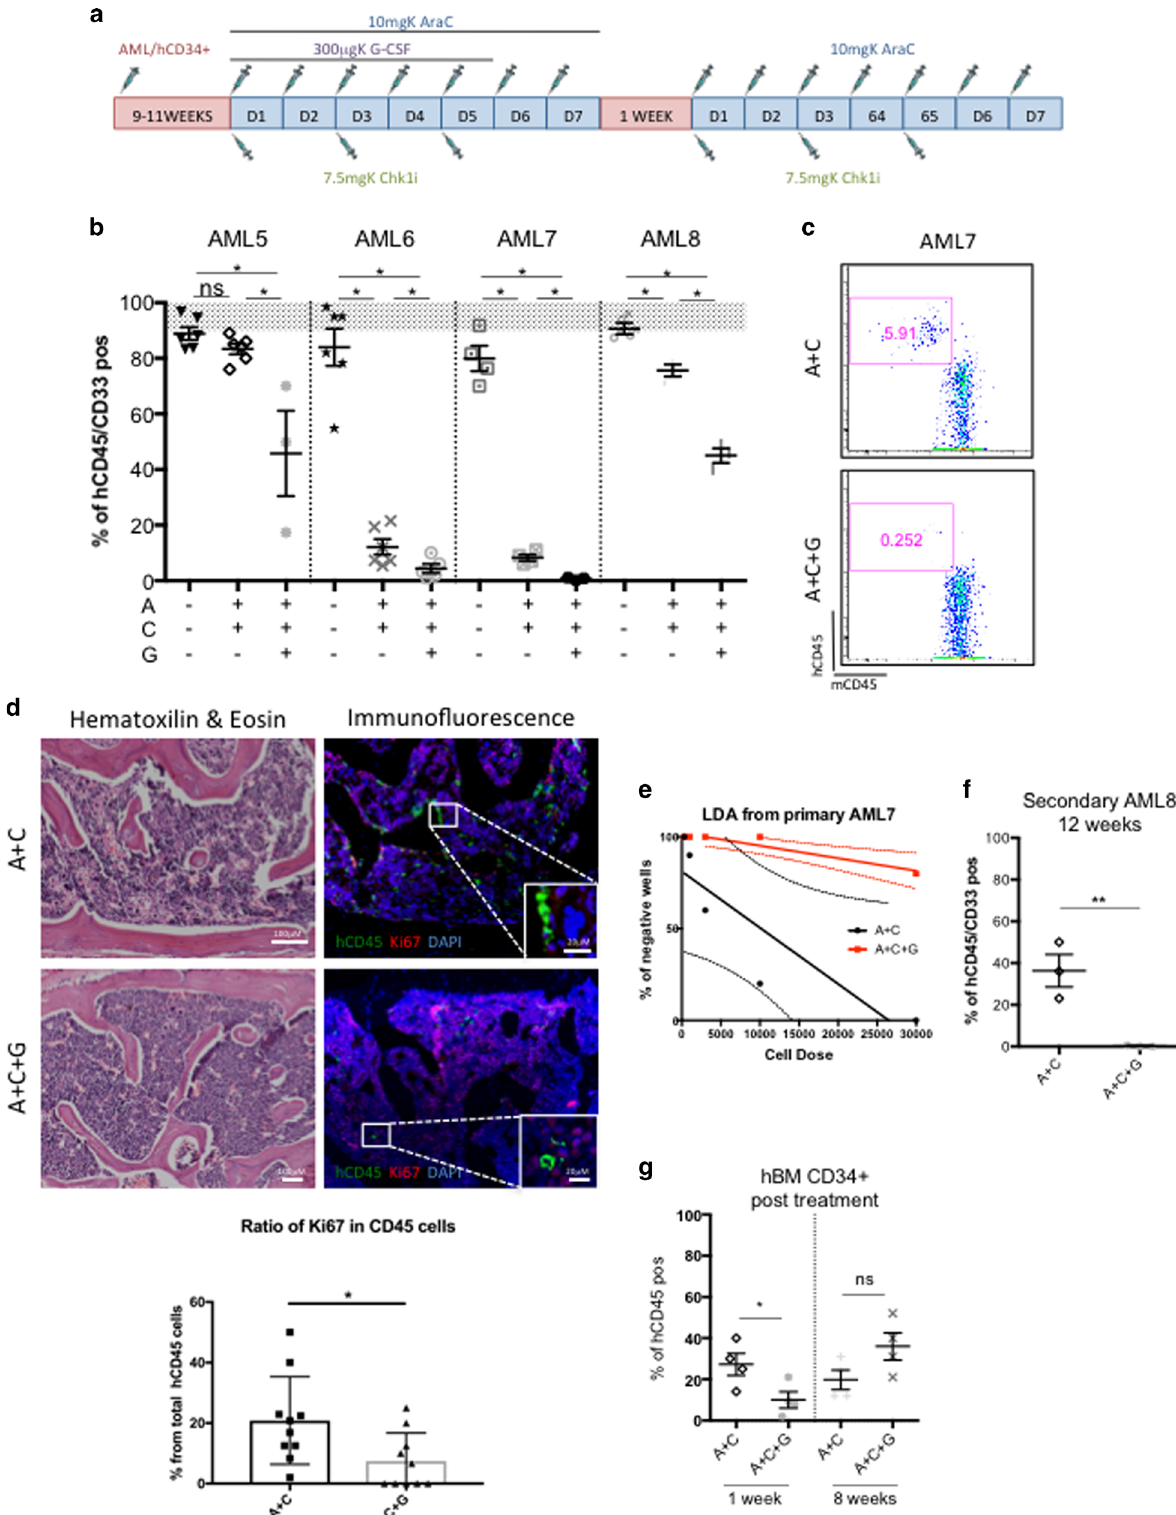
(Fig. 5g). The functionality of the remaining human CD34 + cells was tested by serial transplantation. We observed that cells exposed to the triple treatment were able to engraft in secondary mice at the same frequency as A+C and UT group (Supple- mentary Table